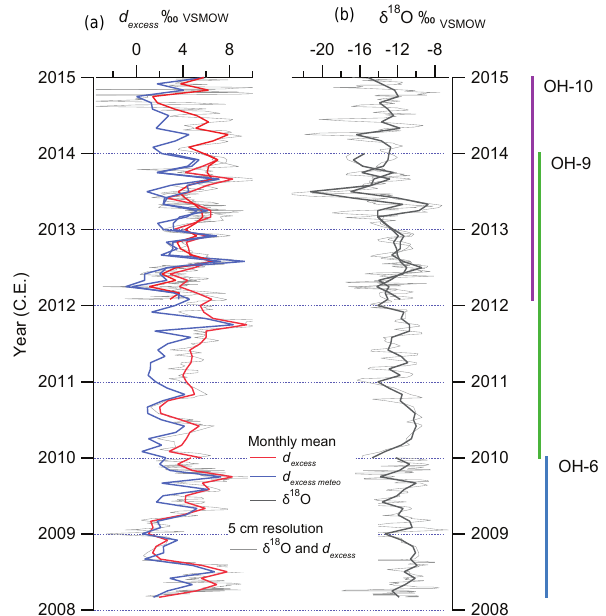
Figure 3. Time series for firn cores OH-6 (light blue line right), OH-9 (green light right) and OH-10 (purple line right) derived for δ 18 O (bold black line middle left panel) and d excess (red line left panel) records using a theoretical d excess ( d excess meteo ) value (blue line left panel). The d excess meteo is calculated from sea surface temperature (SST) and relative humidity (rh) according to Uemura et al. (2008). All three cores are located at the same location within the GPS navigator horizontal error ( <